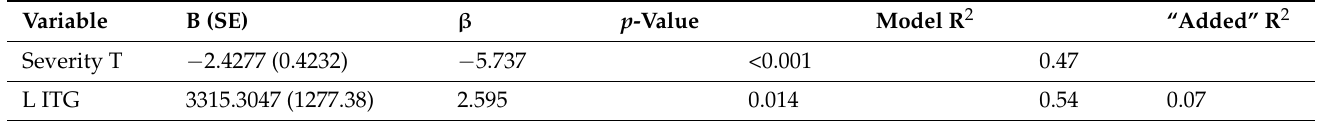
Table 4. Significant predictors of category fluency. Stepwise regression with clinical, demographic and ROIs as predictors. Severity T = total severity score at the fronto-temporal dementia scale; L ITG = left inferior temporal gyrus. The added R-squared from the regression model refers to the additional variance explained by including the given